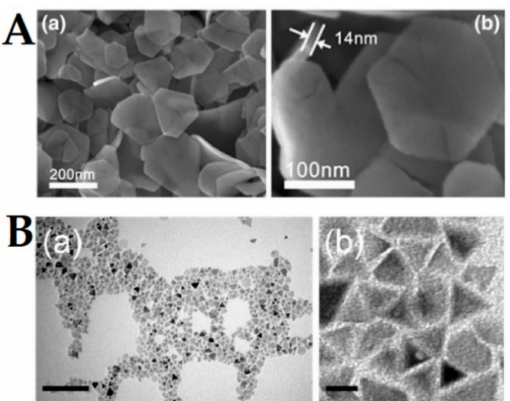
Figure 3. ( A ) SEM images of hexagonal-shaped magnetite nanoplates at di ff erent magnifications. Reproduced from [109] published in Open Access by Springer. ( B ) TEM images of triangle-shaped magnetite ultra-thin nanoplates at di ff erent magnifications. Adapted from [110] with permission from Royal Society of Chemistry, 2020.